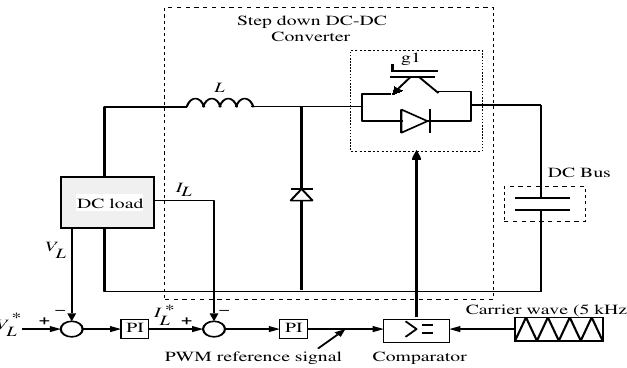
Figure 9. Power converter control system for the